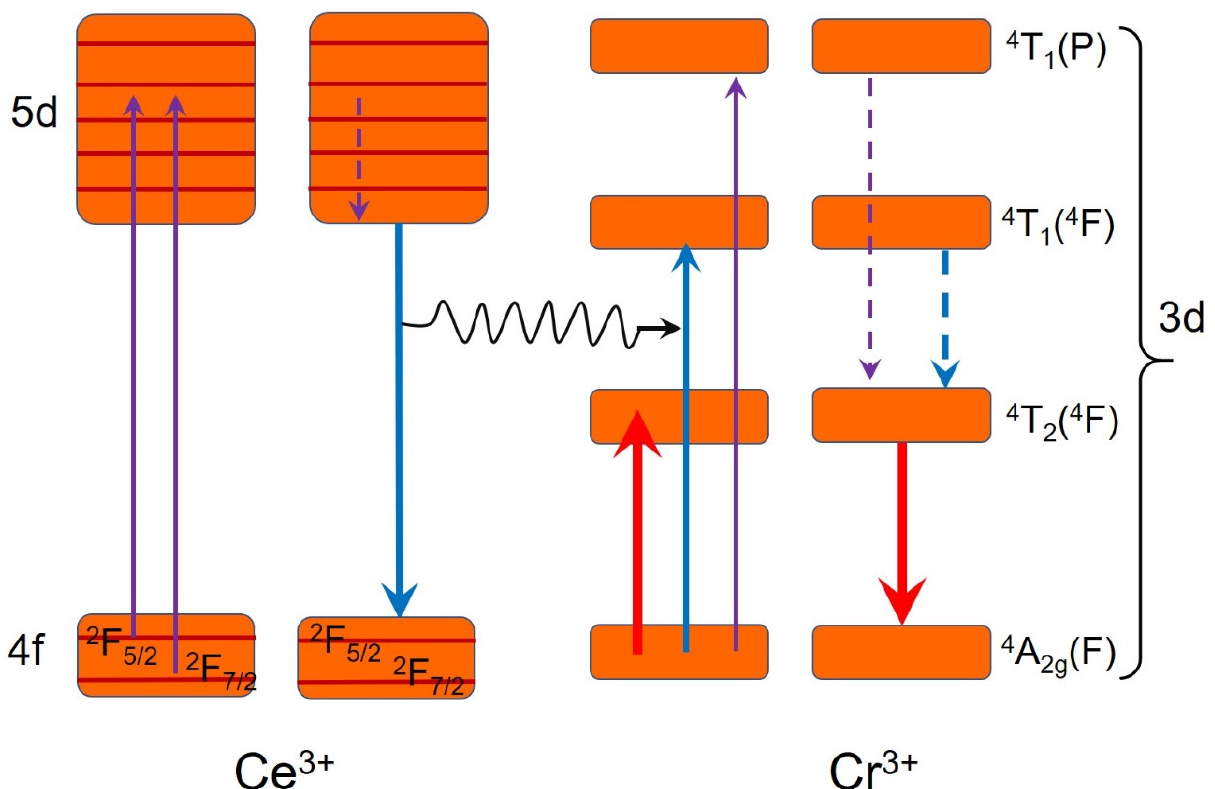
Scheme 1. The mechanism of energy transfer from the CeSc 3 (BO 3 ) 4 host to the Cr 3+ activator and energy conversion processes in the CeSc 3 (BO 3 ) 4 :Cr 3+ phosphor, in which up-pointing arrows indicate the processes of excitation, down-pointing arrows indicate the processes of emission, and the dashed-line arrows indicate the processes of electron